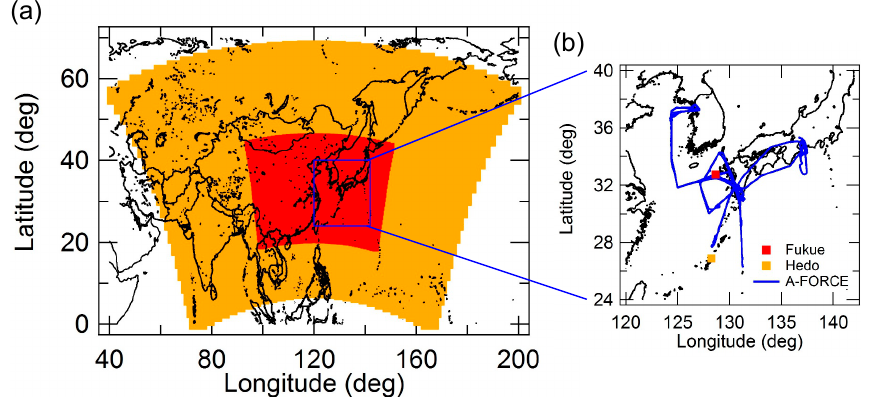
Figure 2. (a) Simulation domain used in this study. The simulations are conducted from 21 March to 26 April 2009 with horizontal resolutions of 360km (outer domain, orange) and 120km (inner domain). (b) The locations of surface measurements at the Fukue and Hedo sites and the flight tracks during the A-FORCE aircraft campaign, which are used to validate the model simulations in this